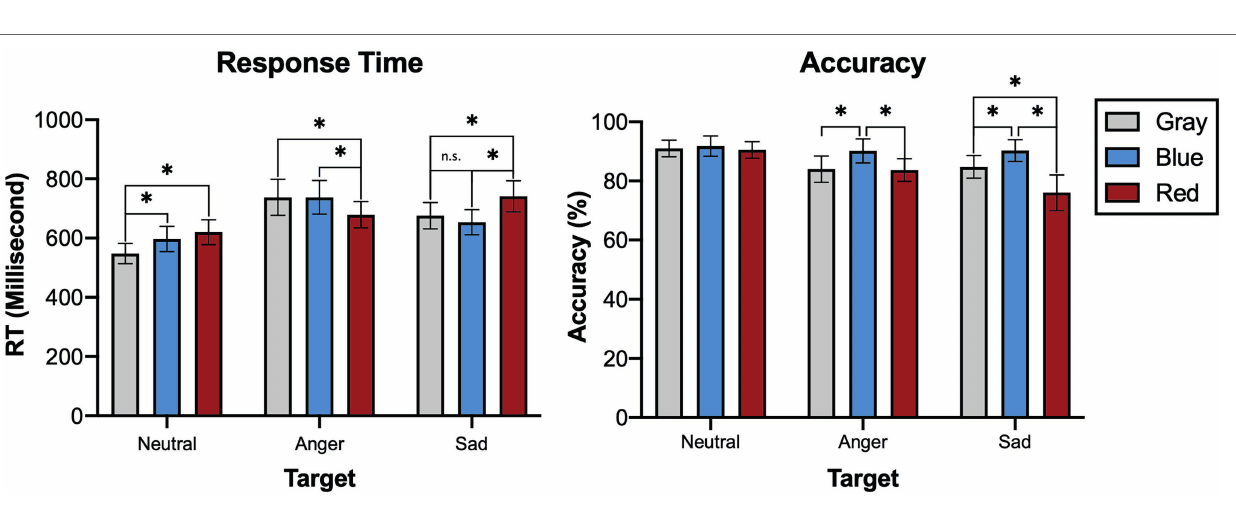
FIGURE 2 | Accuracy and response time for Experiment 1. Bars indicate 95% CIs of means. * p < 0.05; ** p < 0.01; and *** p <